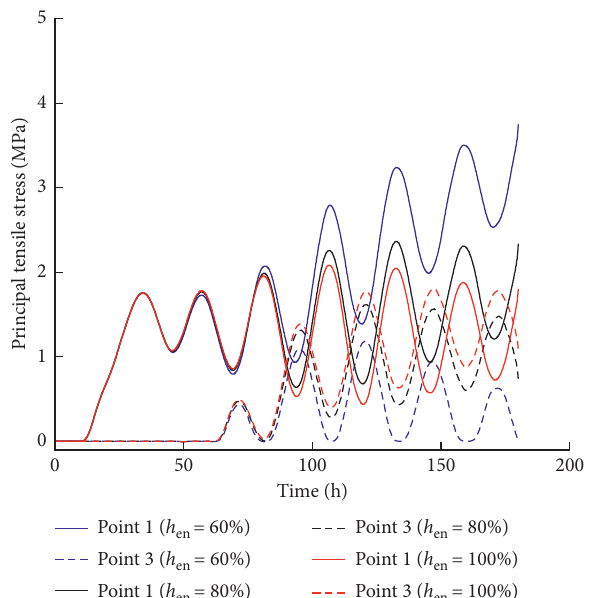
Figure 19: Comparison of time-dependent principal tensile stress distribution at points 1 and 3 (considering the